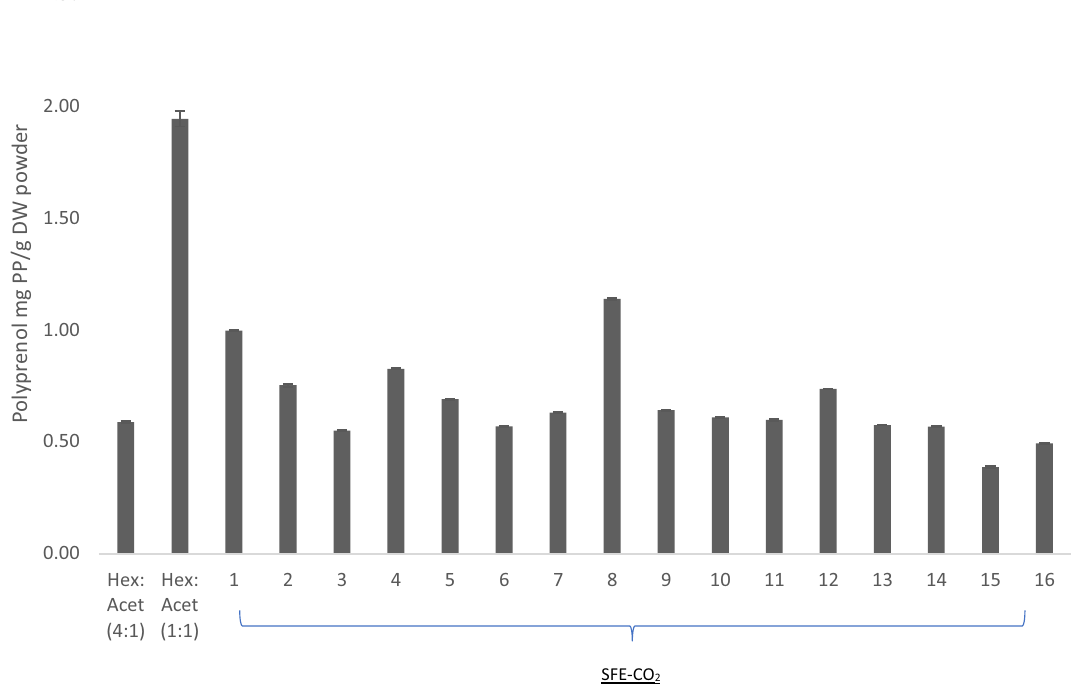
Figure 2. Quantitive analysis of the total polyprenol content (mg g −1 DW) extracted from C. atlantica ‘Glauca’ under two extraction methods; solvent using hexane:acetone (4:1; 1:1, v/v) and 16 different combination of SFE-CO 2 parameters without saponification. The polyprenol content from SFE-CO 2 extractions were based on a dynamic time of 70 min and also without applying saponification on both extraction methods. Each value presents the mean value ± SD. Figure was prepared using Microsoft excel (Version 16.39, Microsoft 365 subscription, data analysis 2019